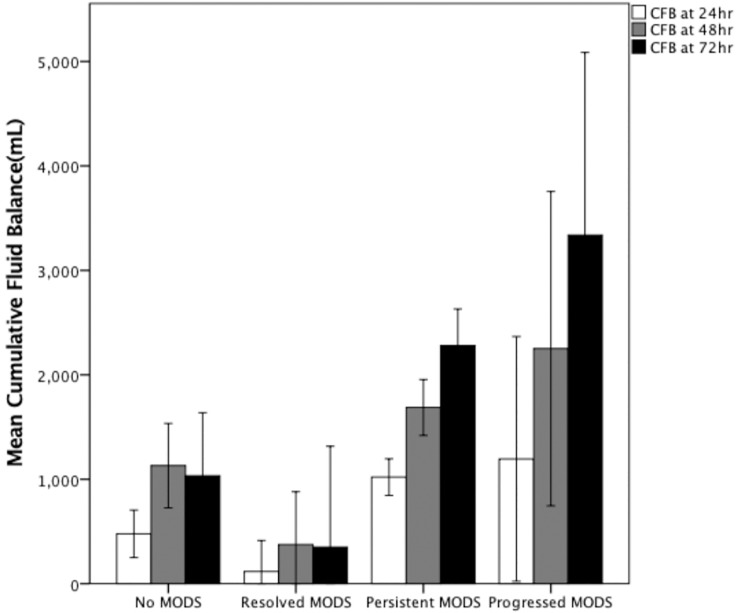
72-hr cumulative fluid balance (CFB) in patients with resolved persistent multiple organ dysfunction syndrome (MODS), progressive MODS, or without MODS from 24 hr to 72 hr after onset of septic shock.Open bars indicate 24-hr CFB; gray bar indicates 48-hr CFB; black bars indicate 72-hr CFB (data expressed as mean ± SEM).